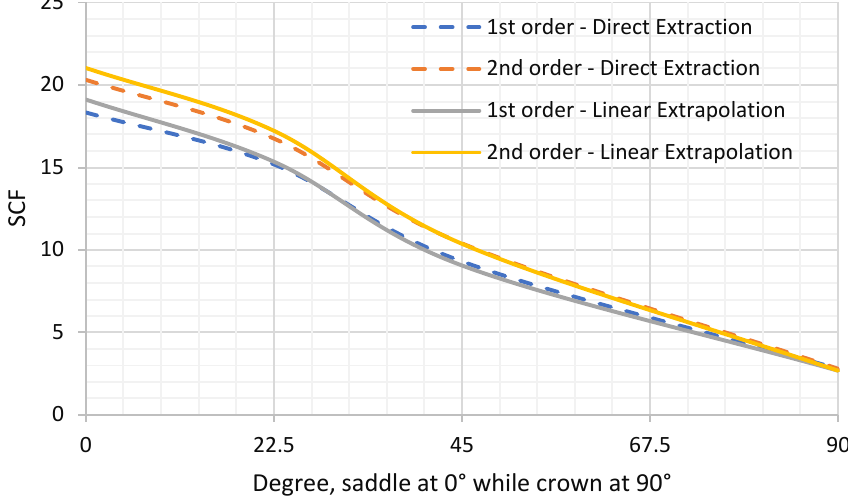
Figure 15. Direct and linear extrapolation of SCFs for first and second-order elements.